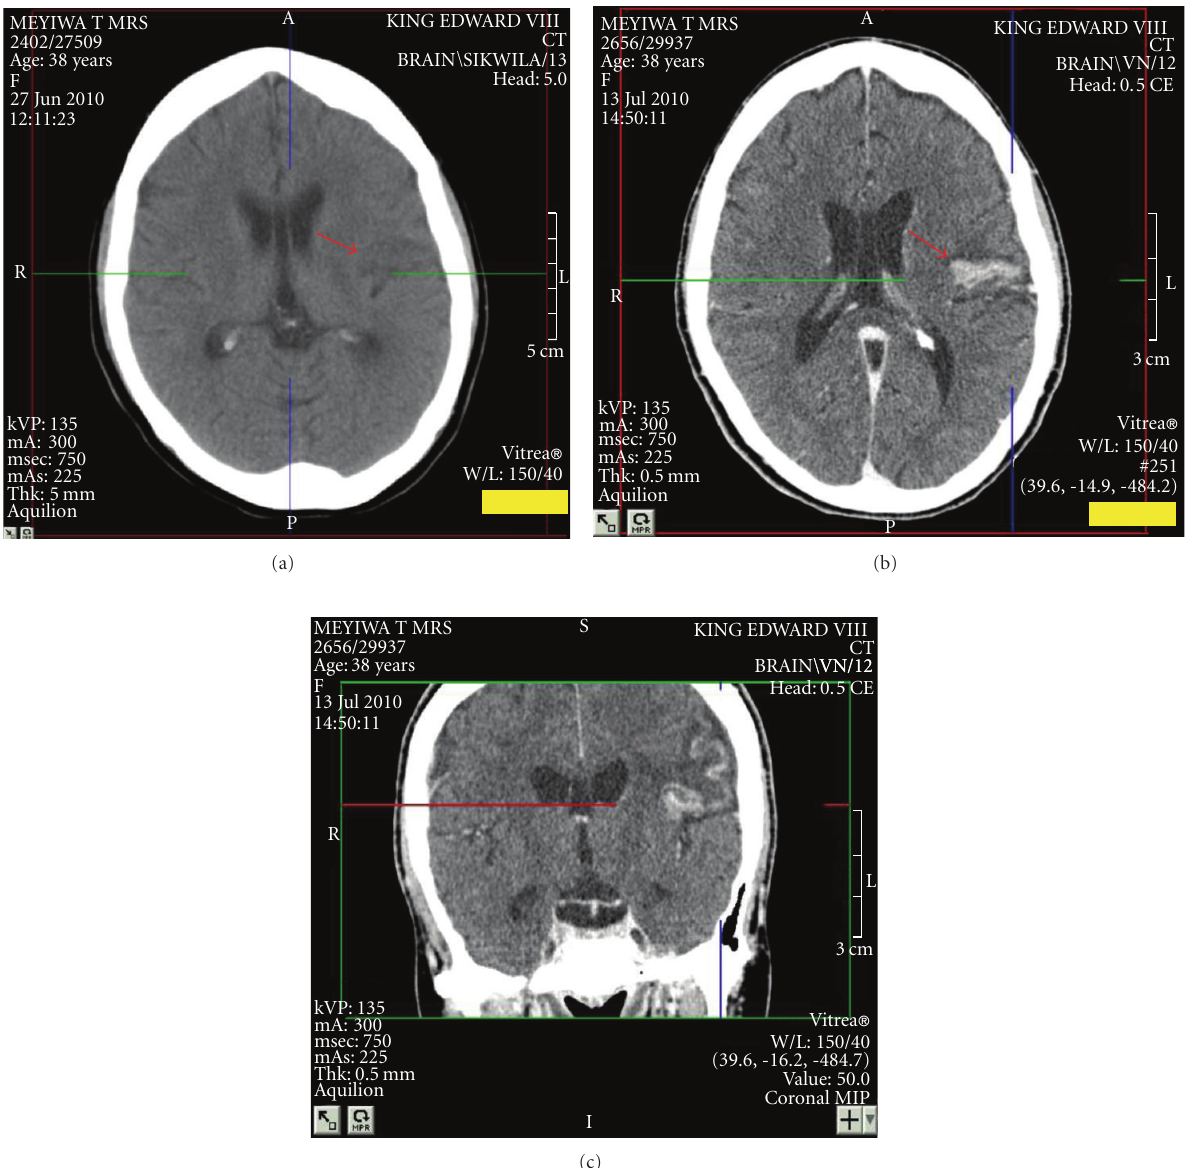
Figure 2: (a) Axial computerised tomography (unenhanced) brain showing a wedge-shaped hypodensity in the left frontopareital area with extension across both gray and white matter, which is in keeping with a cerebral infarct. (b) Axial computerised tomography (enhanced) brain showing hyperdensity in the left-hand side in the area of previous ischaemia. (c) Coronal computerised tomography (enhanced) brain showing hyperdensity in the left-hand side in the area of previous